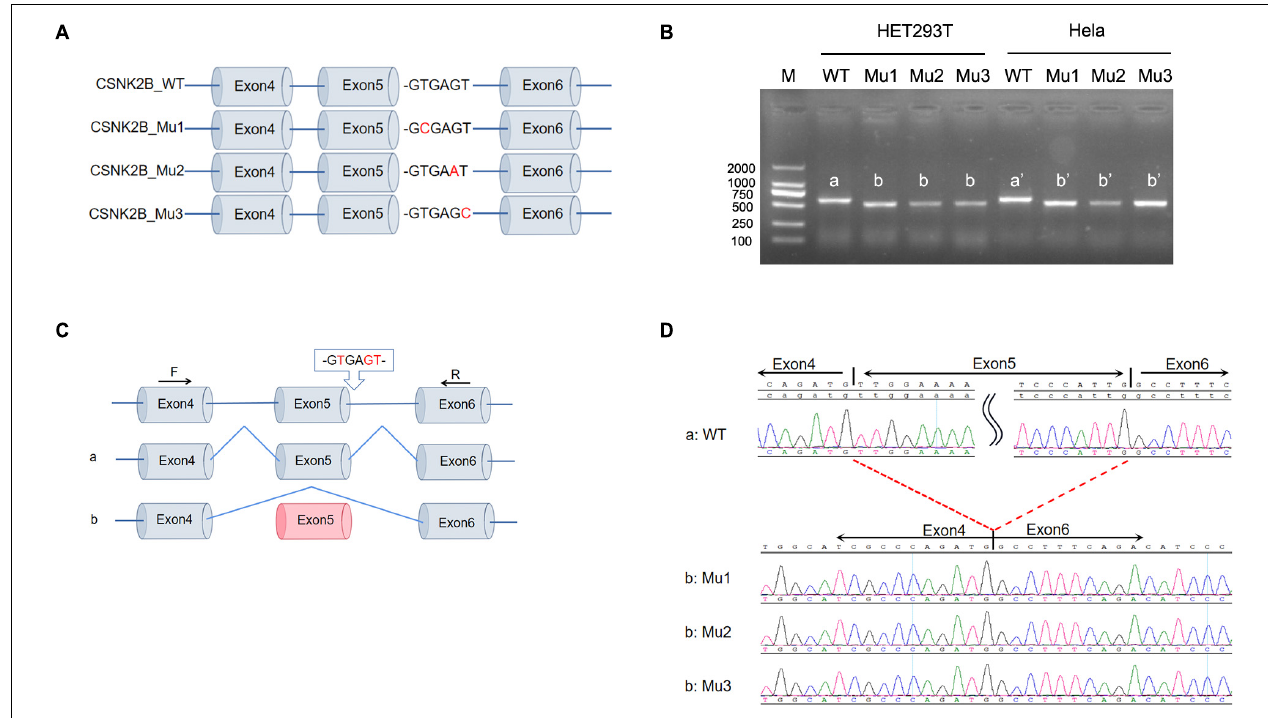
FIGURE 1 | Minigene splicing assay for intron variants. (A) Schematic diagram of minigene plasmid construction. Red bases are targeted sites. (B) Minigene was transfected into HEK293 cells and Hela cells, respectively. A single band was detected by RT-PCR with a lower molecular weight than wild-type CSNK2B . (C,D) Sequencing of the above bands revealed that three splicing variants (c.367 + 2T > C, c.367 + 5G > A, and c.367 + 6T > C) all resulted in exon 5 skipping and early termination of the amino